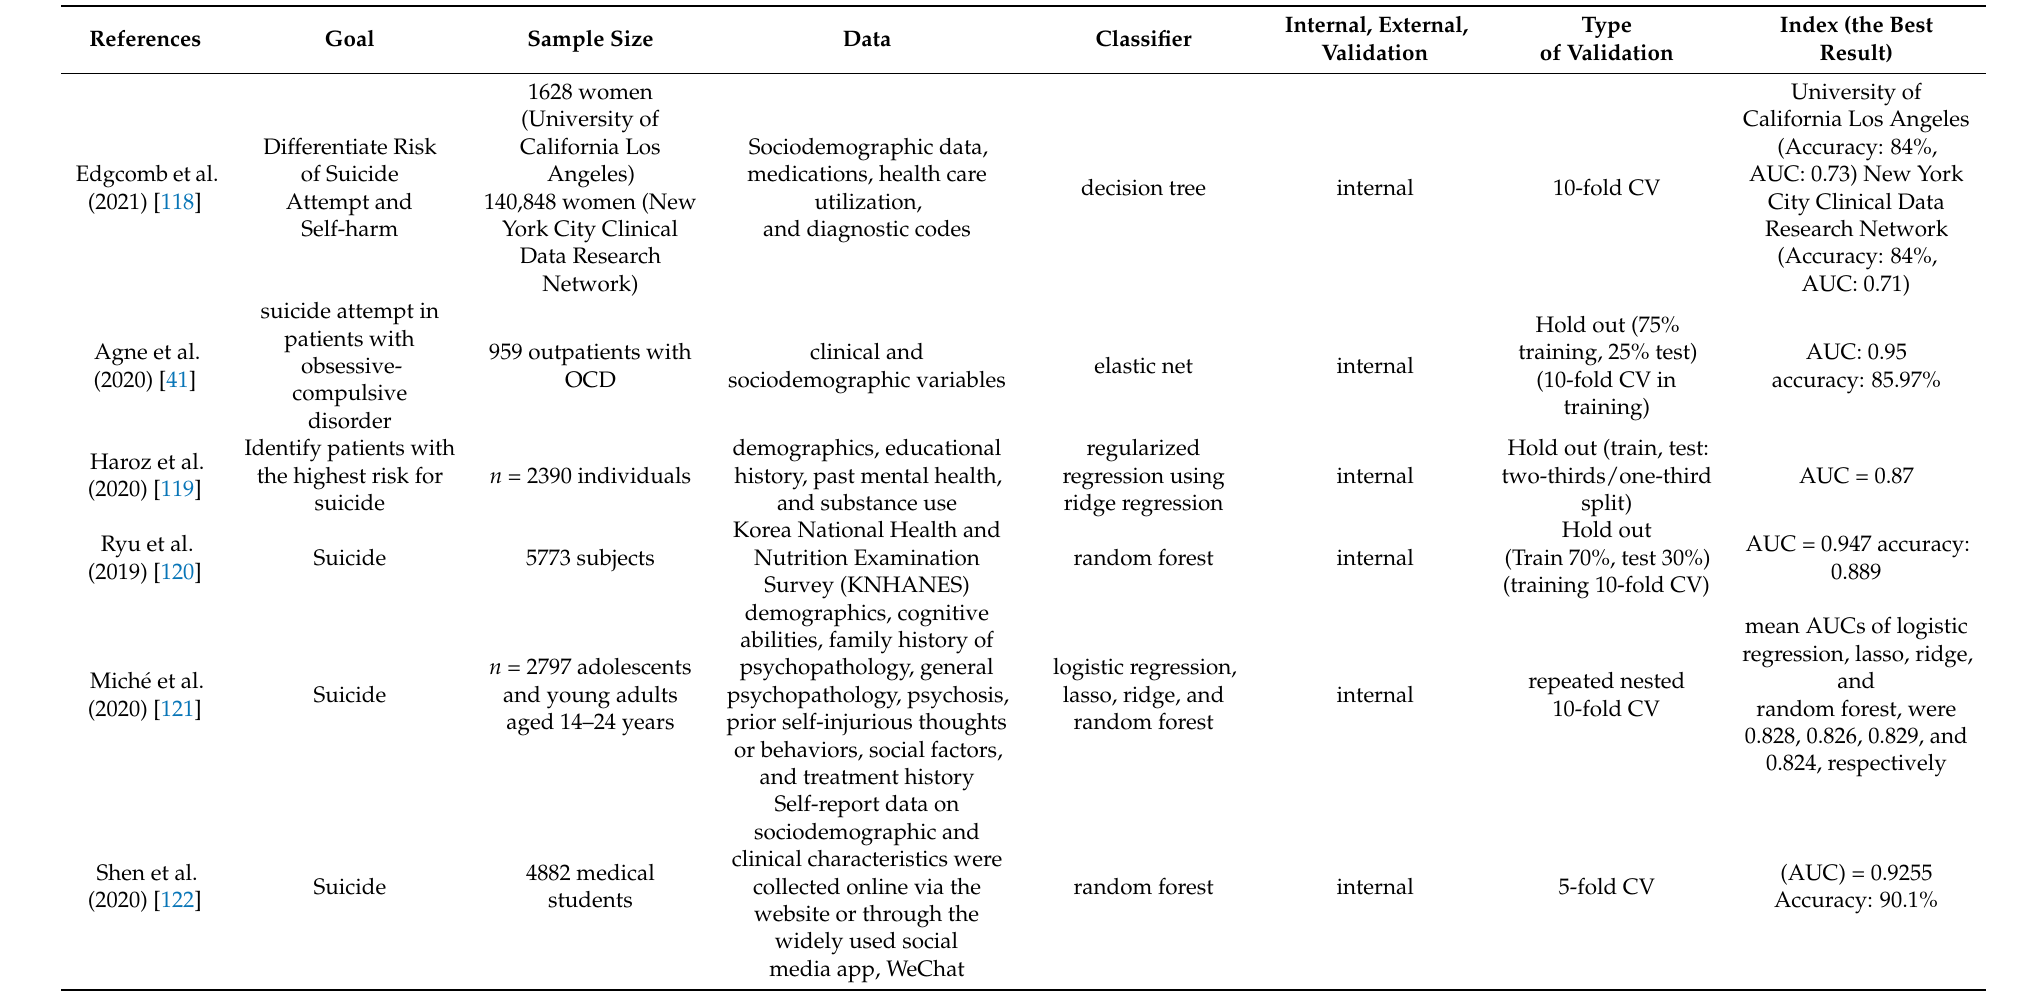
Table 10. CAD methods for suicide prediction